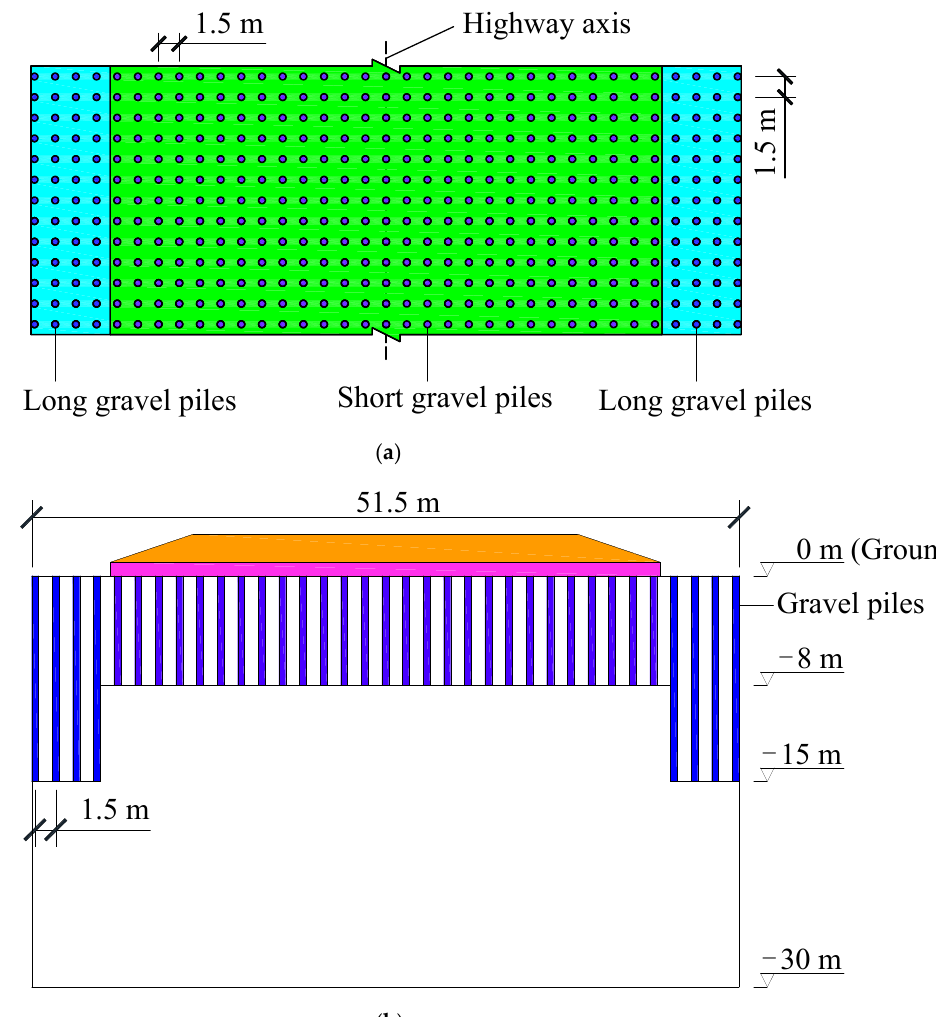
Figure 5. Layout of the subarea long-short gravel piles scheme. ( a ) Planar layout. ( b ) Cross-sectional layout.